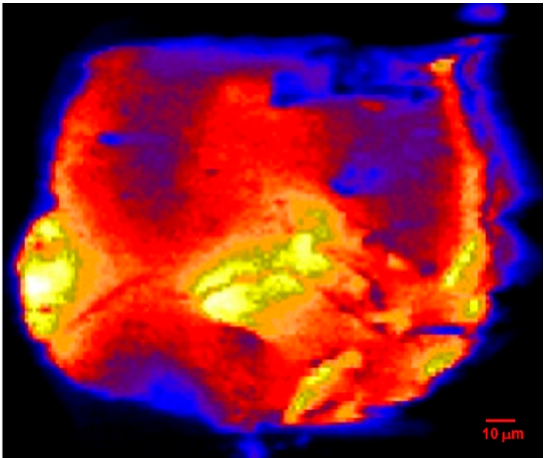
Figure 8. Complete XRF image of cosmic spherule WestIslipB depicts the sulfur distribution throughout the micrometeorite surface; yellow depicts the highest relative amounts of S while blue depicts the lowest relative amounts of S. Sulfur distribution is similar in the maps of both micrometeorites in Figures 7 and 8.